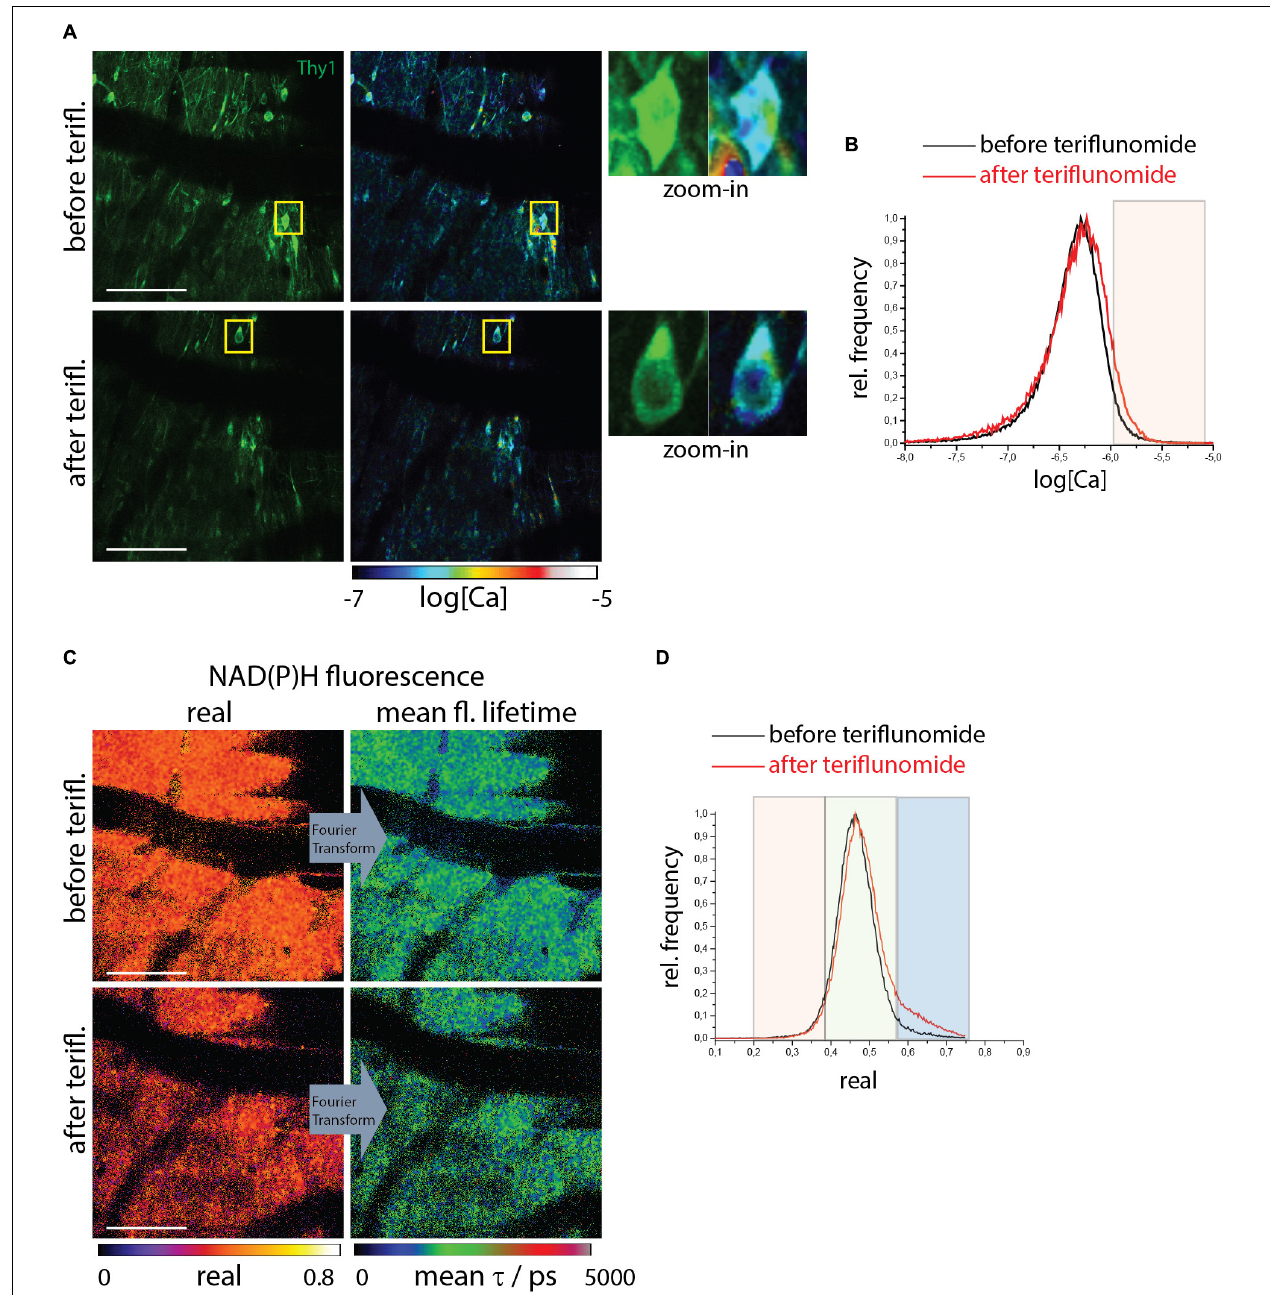
FIGURE 3 | NOX enzymes activation by NAD(P)H-FLIM and neuronal dysfunction by FRET-FLIM of TN L15 in the brain stem of healthy mice under treatment with teriflunomide. (A) Fluorescence intensity images of an untreated (upper image) and treated (lower) brain stem of healthy CerTN L15 x LysM tdRFP mice: Cerulean and Citrine fluorescence in Thy 1 cells (green). Corresponding log[Ca] images of the regions shown by the fluorescence intensity images. Yellow frames depict the regions of untreated and treated neurons, respectively, displayed enlarged. (B) Histograms of neuronal Calcium in log[Ca] with and without teriflunomide treatment. (C) NAD(P)H fluorescence real part images and mean NAD(P)H fluorescence lifetime images of the same untreated (upper image) and treated (lower) brain stem region of the CerTN L15 x LysM tdRFP mouse as in (A) . (D) Histograms of the real part of the NAD(P)H phasor vector depicting the NAD(P)H-dependent enzymes activation in the images in (C) . (A–D) Are representative data for n = 2 healthy mice ( Supplementary Table S1 ). Scale bars represent 100 µ m.